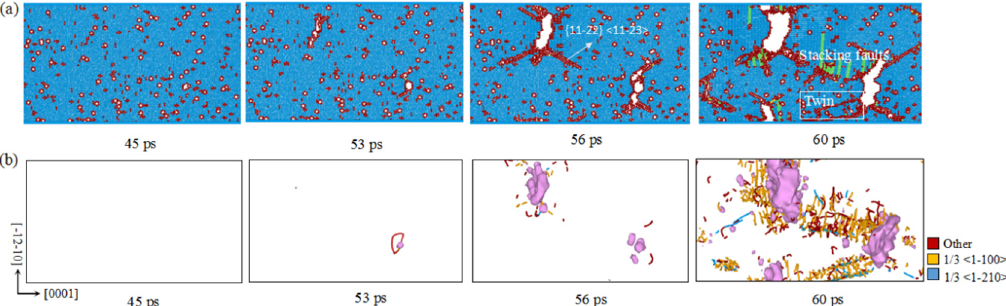
Figure 5. Void evolution of the sample with C v = 1.0% at different time points during initial spallation loading along the [0001] direction. ( a ) Atomic configurations of a chosen section of the spall region. ( b ) Mechanism of void growth based on dislocation emission is analyzed using DXA: 1/3 <1–100> partial basal dislocations, 1/3 <1–210> partial prismatic dislocations, other dislocations (mainly 1/6 <20–23> and 1/9 <01–13> partial dislocations), etc., are presented.